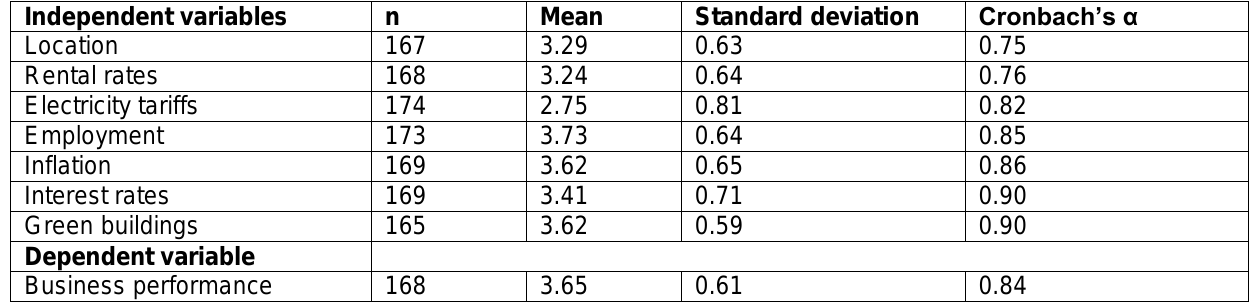
Table 4: Mean, standard deviation and cronbach alpha scores for each factor Independent variables n